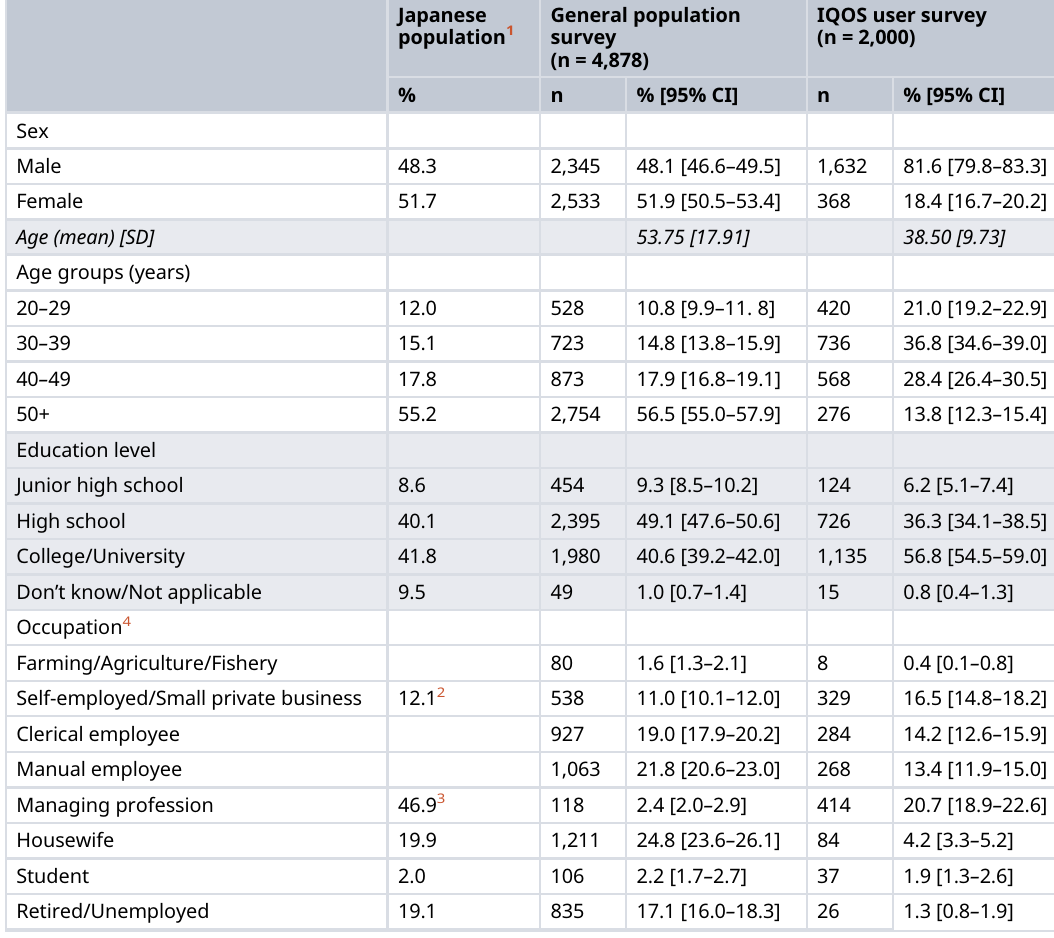
Table 1. Sample characteristics of each survey and the distribution of the Japanese general